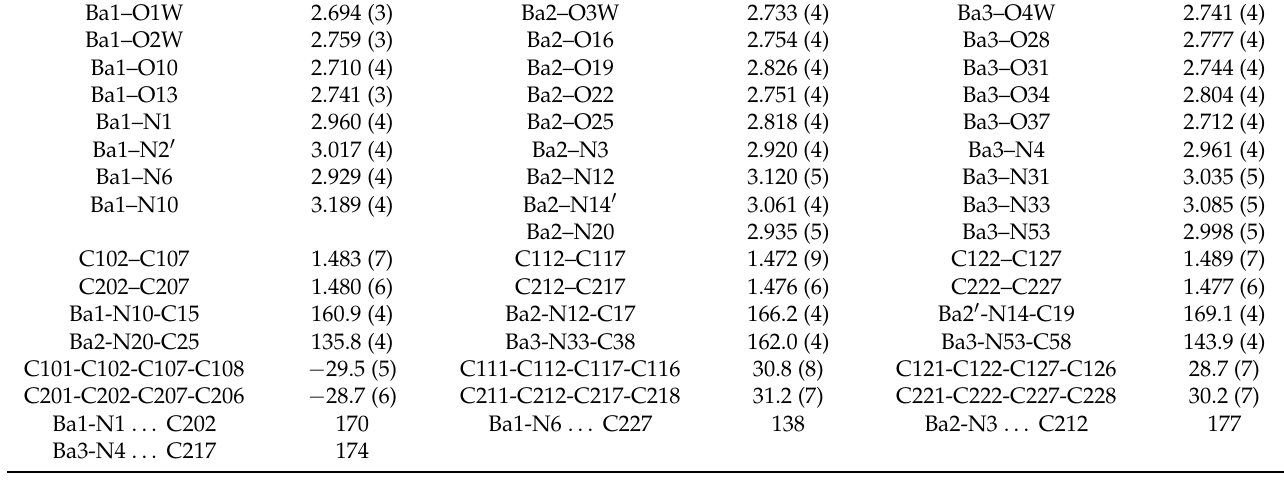
Table 3. Important bond parameters [Å, ◦ ] of compound 5 .